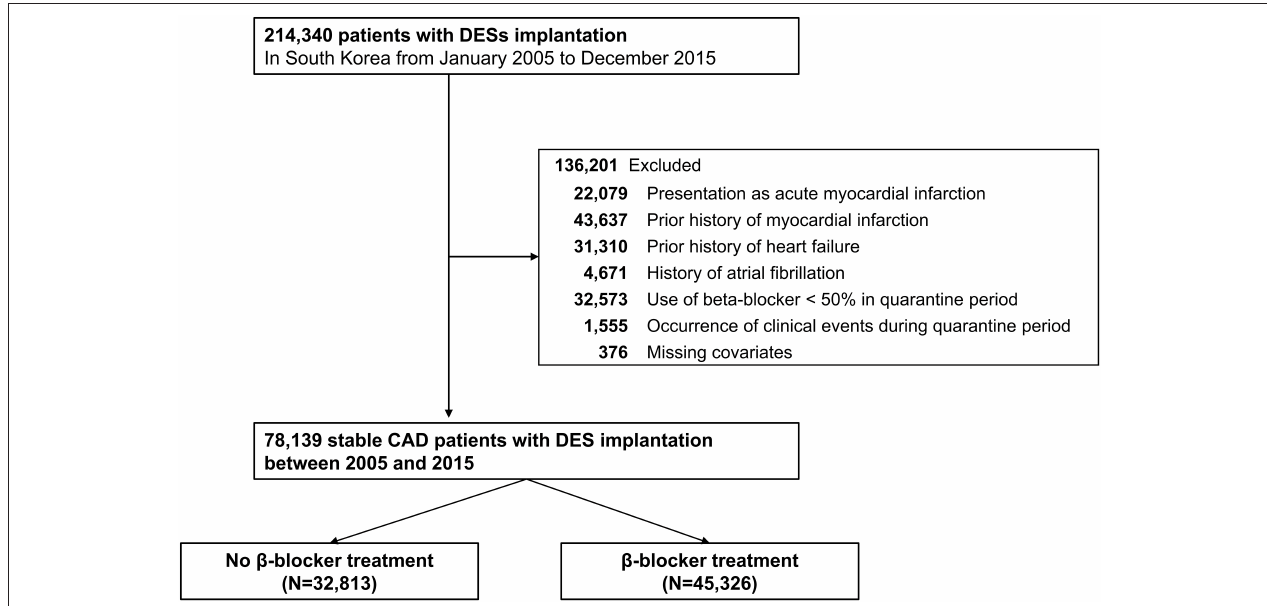
FIGURE 1 | Flow chart of the study population. CAD, coronary artery disease; DES, drug-eluting stent.